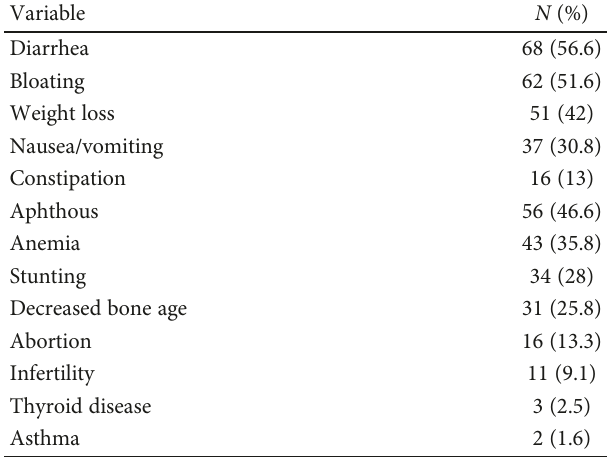
Table 1: Frequencyofgastrointestinal(GI) andnon-gastrointestinal (non-GI) symptoms in the patient group at the